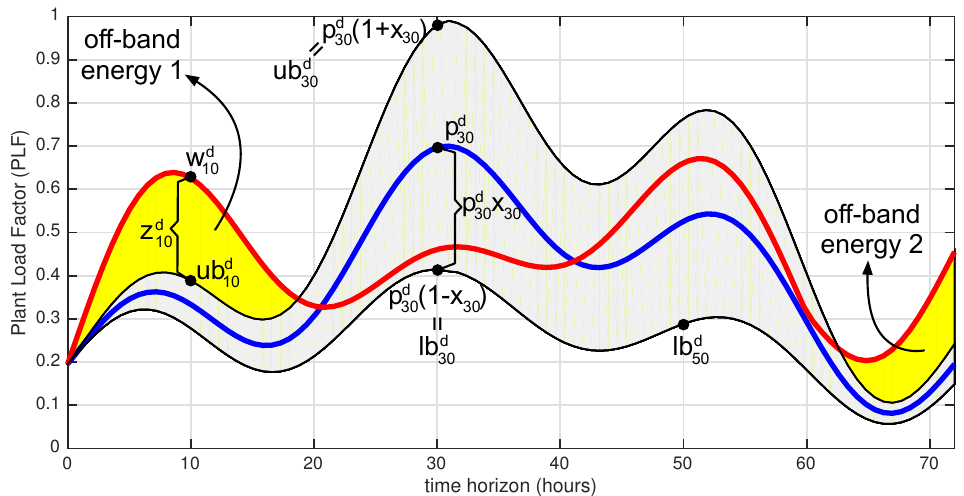
Figure 8. A wind-power band (grey) crafted after a forecast (blue), for some day d , and the actual process